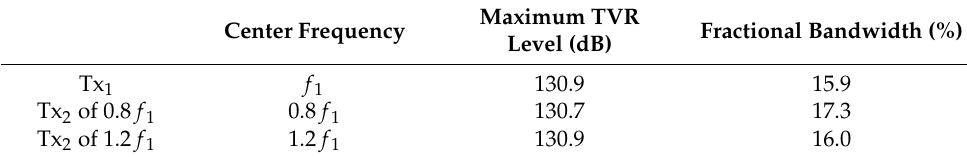
Table 2. Acoustic characteristics of the designed Tx 1 and two Tx 2 transducers.